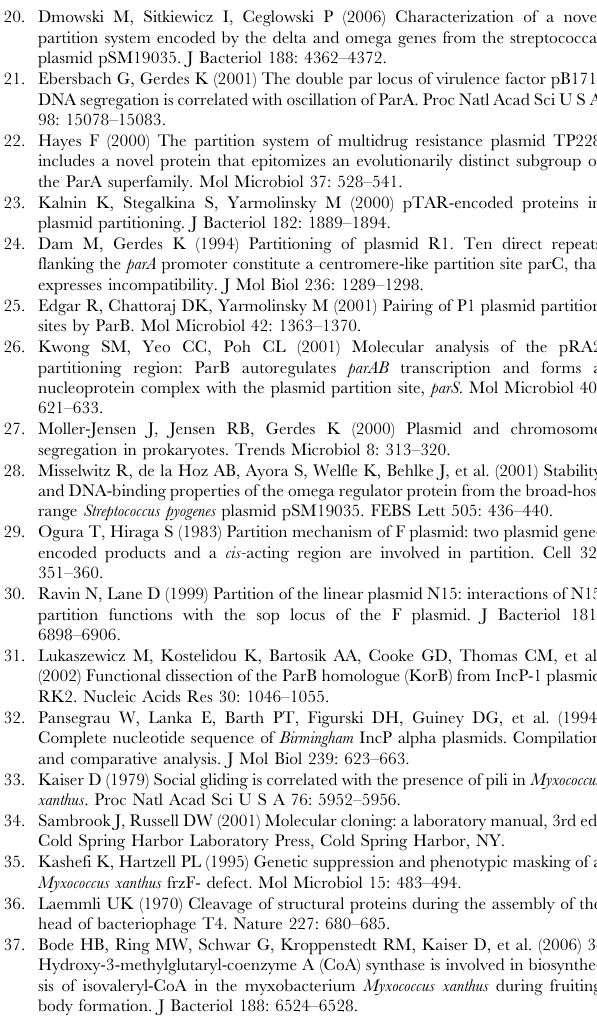
Figure S3 Agarose gel electrophoresis analysis of the pZJY41 derivates. 6 6 10 8 cells were used to extract the plasmid for each lane. Lane1, pZJY41; lane 2, pXS11; lane 3, pXS13, lane